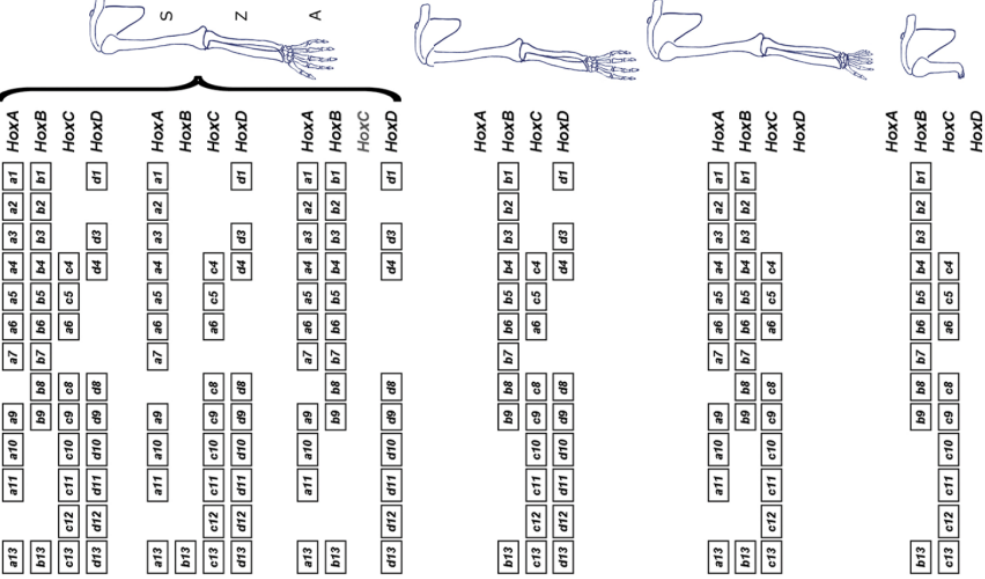
Figure 3. Irrelevance of the Hoxb and Hoxc clusters for limb development. On top, the